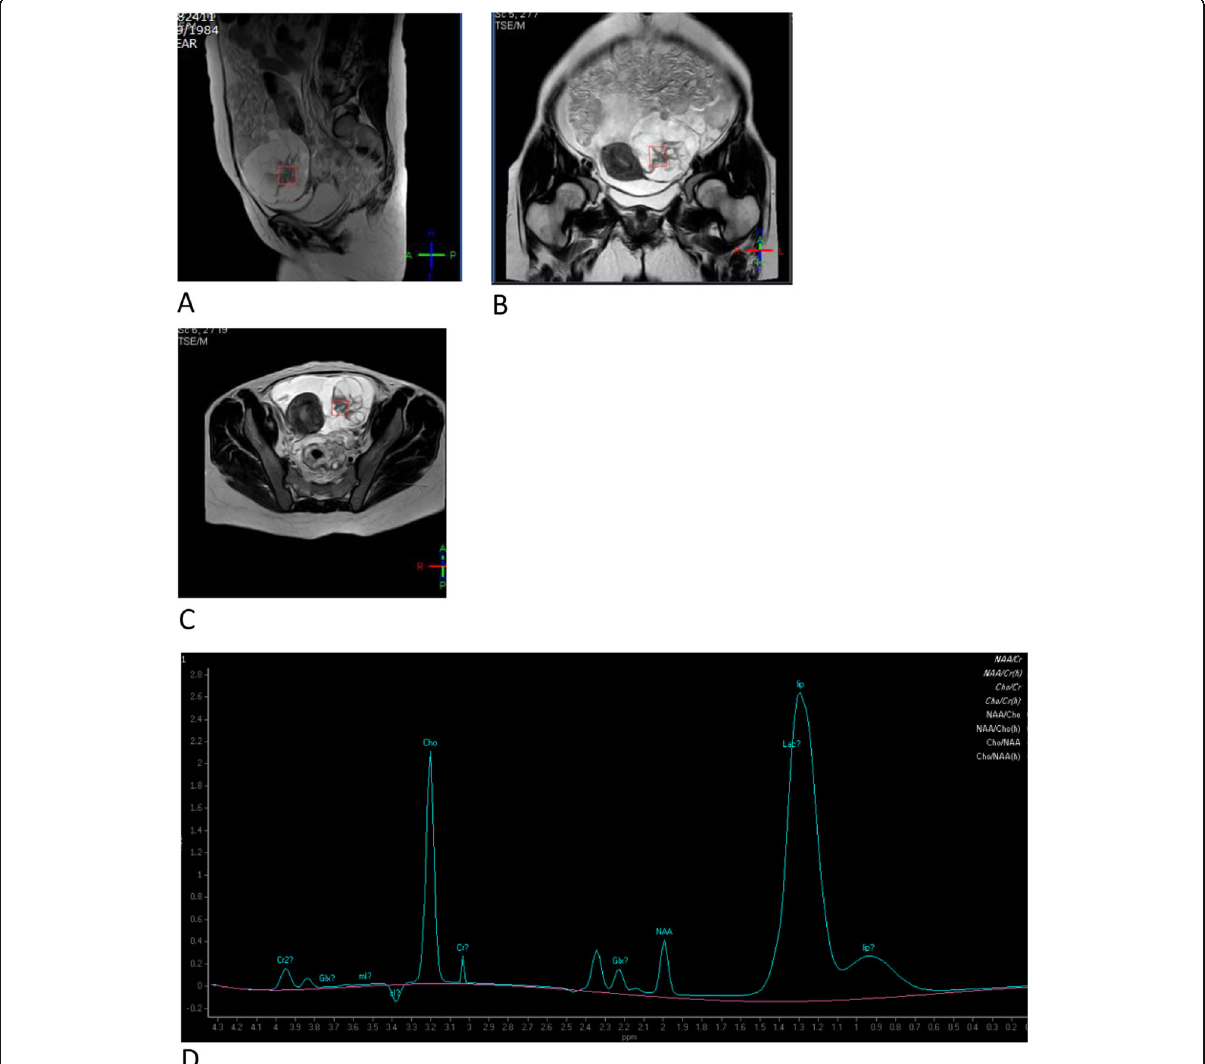
Fig. 3 A 33-year-old woman with rectal carcinoma metastatic to both ovaries. a – c Sagittal, coronal, and axial T2-weighted images respectively showing voxel in the center of solid part of ovarian mass. Images also show omental cake as well as rectal mass seen in c . d MR spectroscopy showing sharp choline peak with Cho/Cr ratio 7. Also sharp lipid peak as well as small NAA